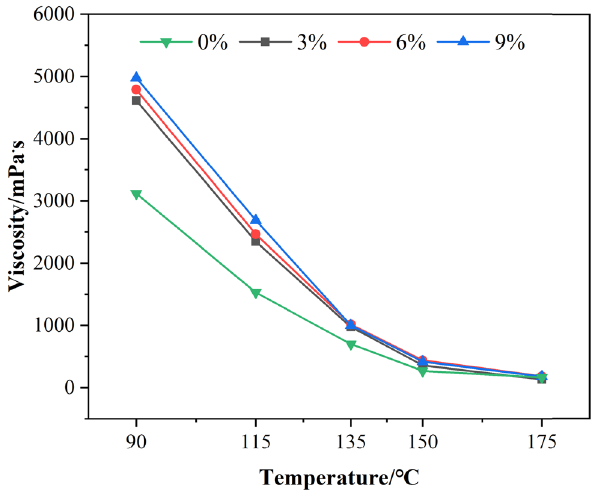
Figure 1: Brook fi eld viscosity test